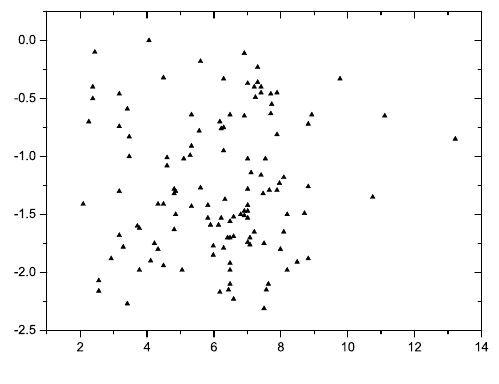
Figure 4: Total metallicity [ Fe/H ] in function of W 0 .